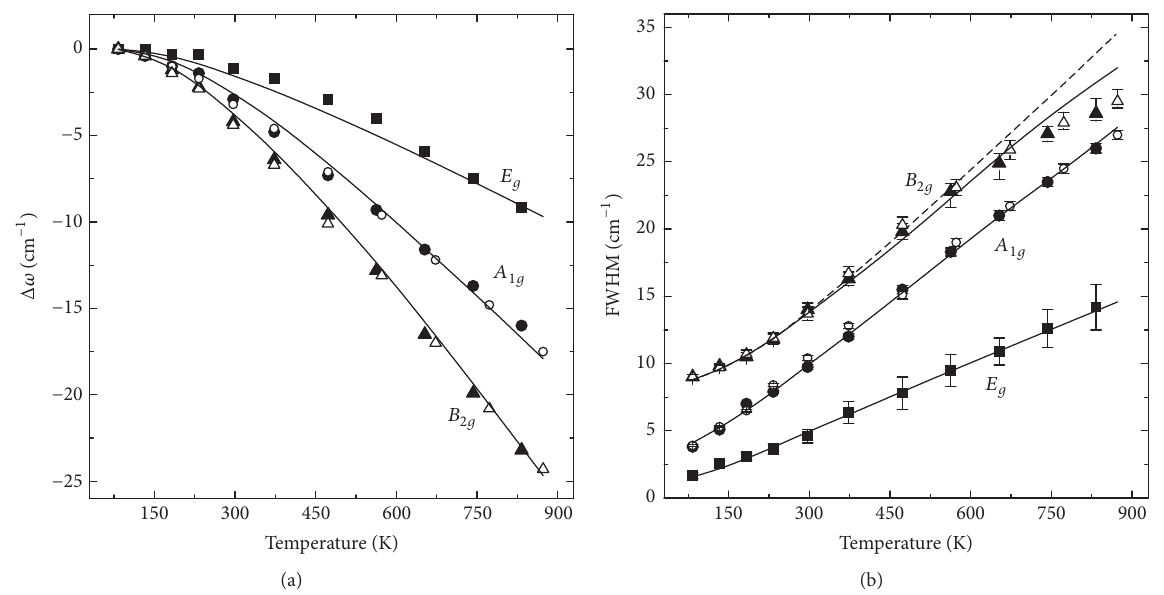
Figure 3: Temperature dependence of (a) frequency shifts and (b) linewidths as FWHMs, of the Raman modes 𝐸 𝑔 , 𝐴 1𝑔 , and 𝐵 2𝑔 of rutile SnO 2 . The solid and open symbols represent the experimental data from powder and single crystal samples, respectively. Solid curves are the theoretical fittings with a full calculation of the kinematics of three-phonon and four-phonon processes. The dashed curve was calculated without considering the frequency dependence of 𝐷 0↓ (Ω) and the number of decay channels, at elevated temperatures. Reprinted figure with permission from Lan et al. [26]. Copyright by the American Physical Society.